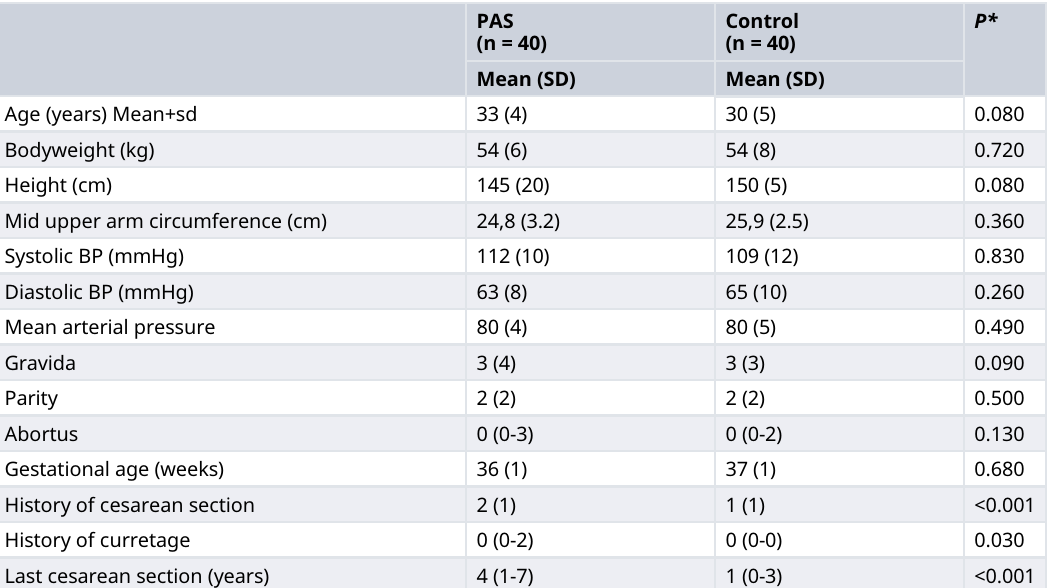
Table 1. Patients